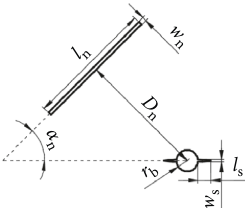
Figure 2: Quasi-two-dimensional analysis